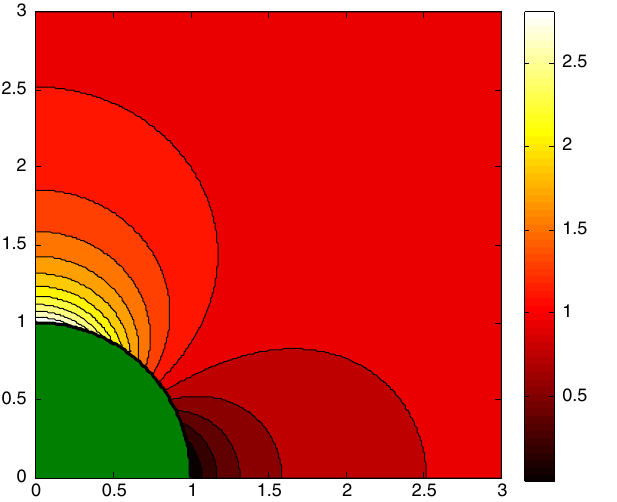
FIG. 13. Same as Fig. 12 but for photoemission.